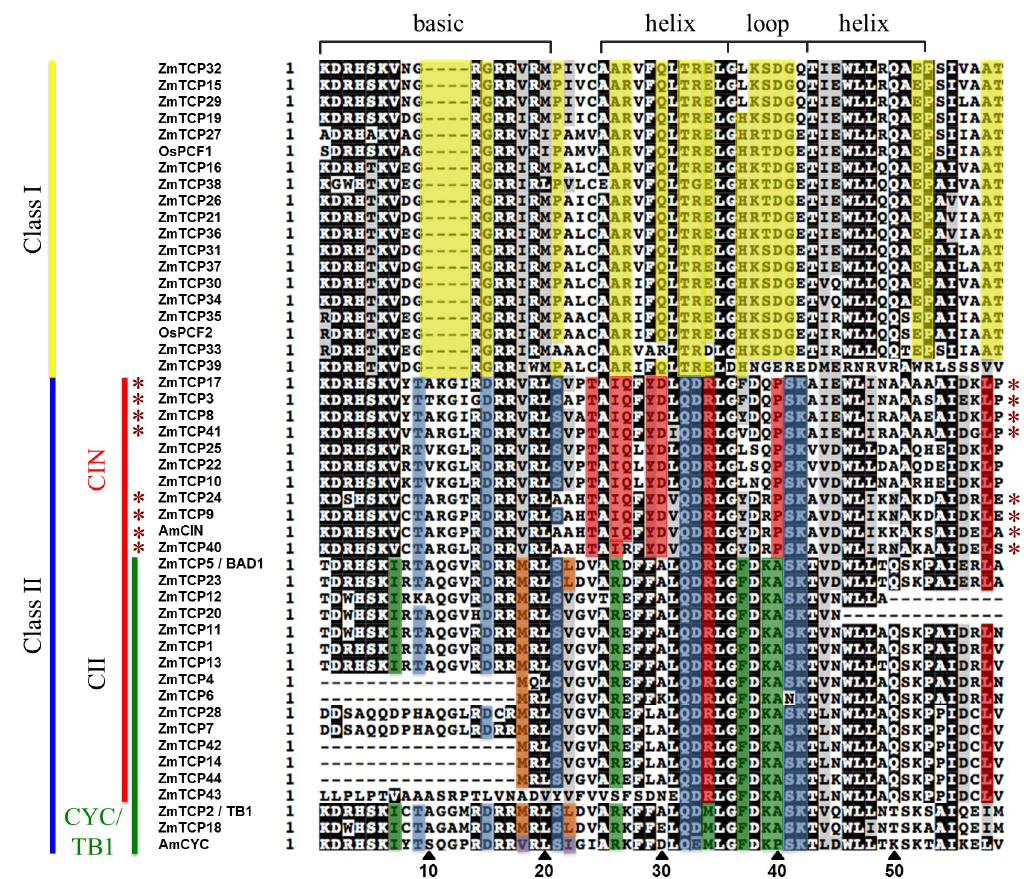
Fig 4. Classification of Z . mays (Zm) TCPs. The TCP motifs identified in 44 ZmTCPs (http://grassius.org/grasstfdb.html) were aligned with subgroup specific TCPs from Oryza sativa (Os) OsPCF1/2, Antirrhinummajus CINCINNATA (AmCIN) and CYCLOIDEA (AmCYC) and Z . mays TEOSINTE BRANCHED1 (ZmTCP02/TB1) (CYC/TB1 green). A number of proteins carry truncated TCP motifs at their N- or C-terminus (ZmTCP04, ZmTCP06, ZmTCP12, ZmTCP14, ZmTCP20, ZmTCP42 and ZmTCP44) or incomplete versions of the TCP-motif within their amino acid sequence (ZmTCP07, ZmTCP28, ZmTCP43). The ZmTCPs were assigned to the (sub)groups based on amino acid conservations (Class I, yellow; Class II, blue; CIN, red and CYC/ TB1, green with AmCYC-like TCPs in purple and TB1-like TCPs in orange) [29] A new CII subgroup shares sequence homology with CIN-TCPs and CYC/TB1-TCPs. Asterisks indicate TCPs with potential miR319a target sites identified in their coding gene sequences (S9